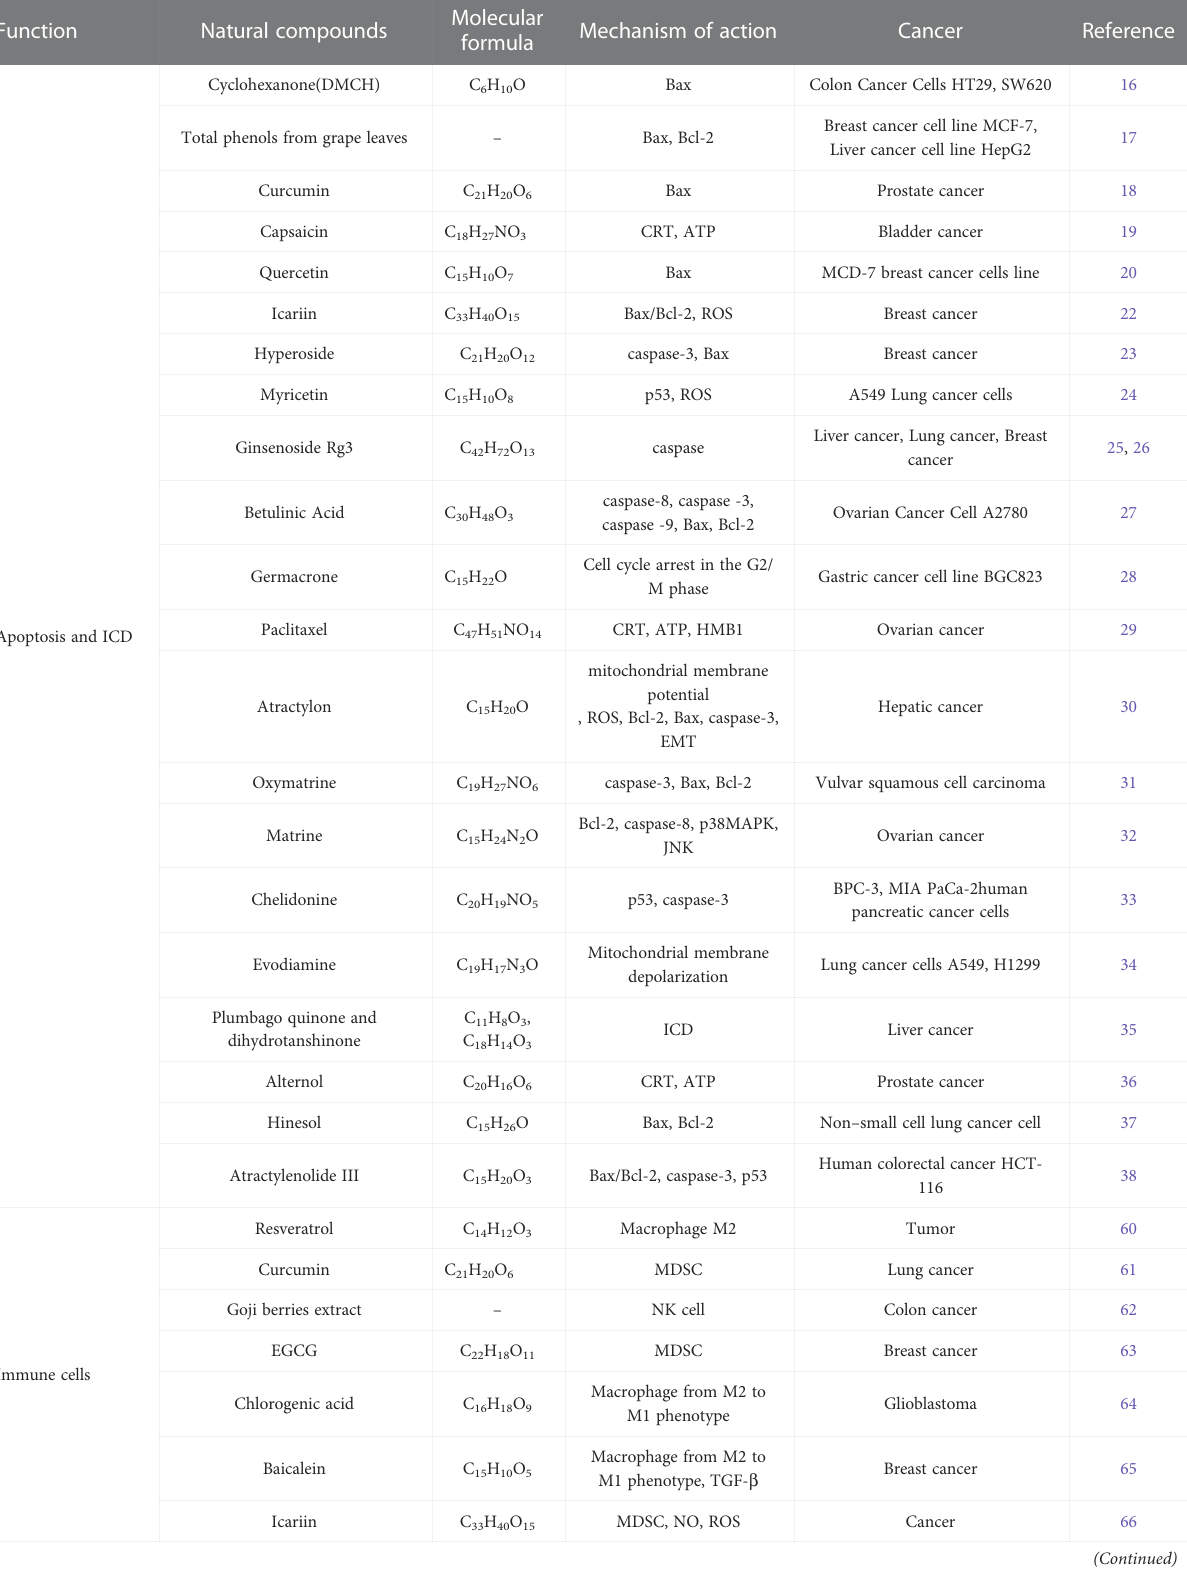
TABLE 1 Natural compounds for the treatment of malignant